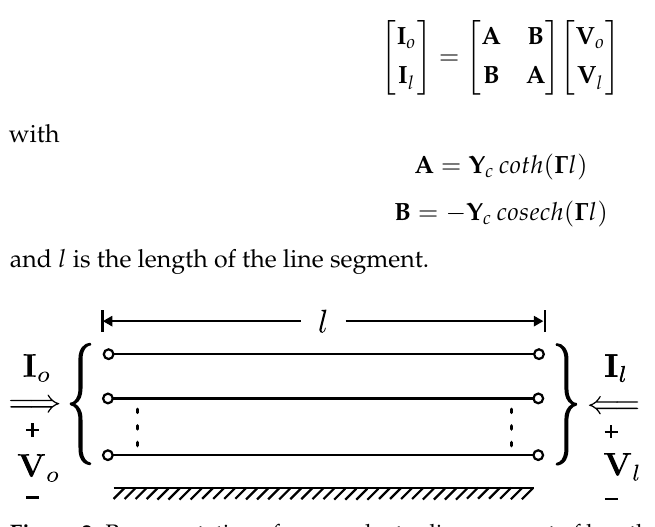
Figure 2. Representation of a n-conductor line segment of length “ l ”.